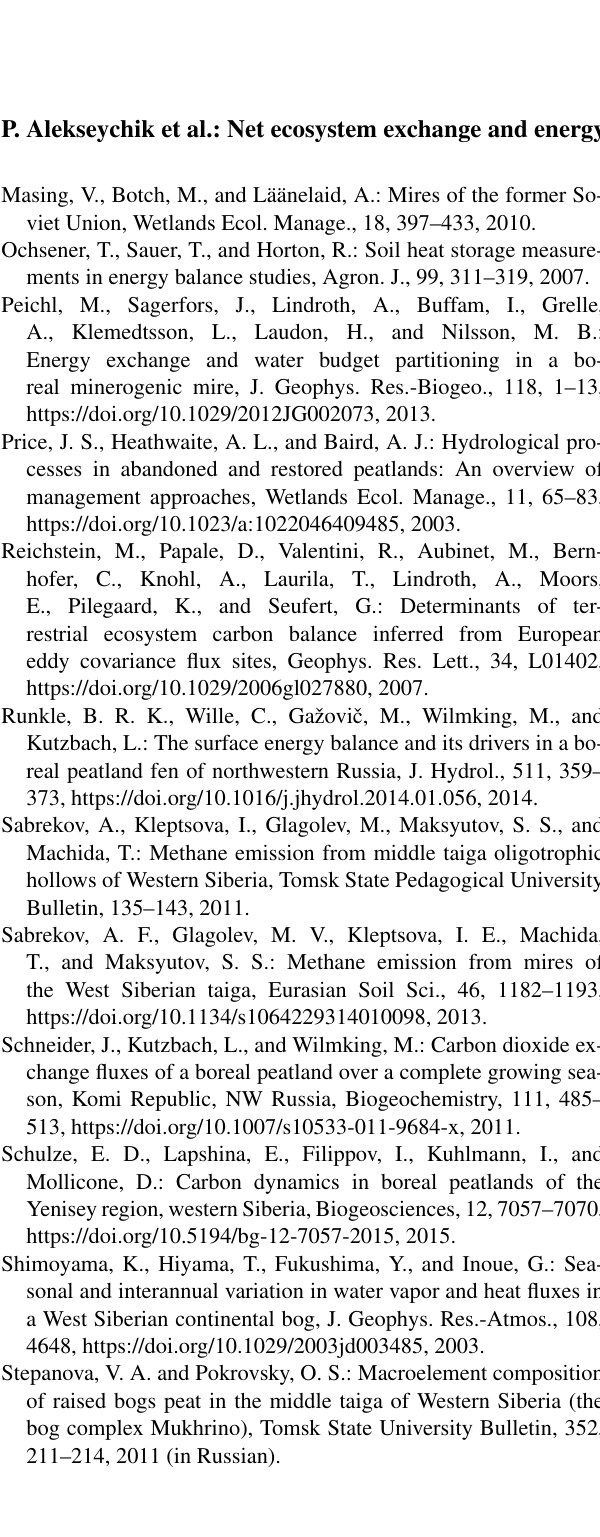
table position, J. Geophys. Res.-Biogeo., 112,